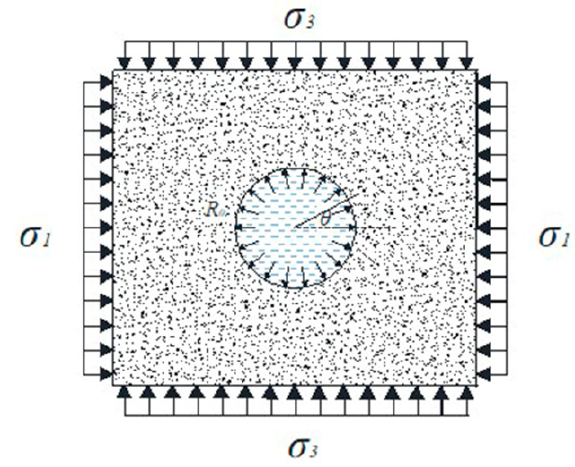
Figure 1. Mechanical model diagram.